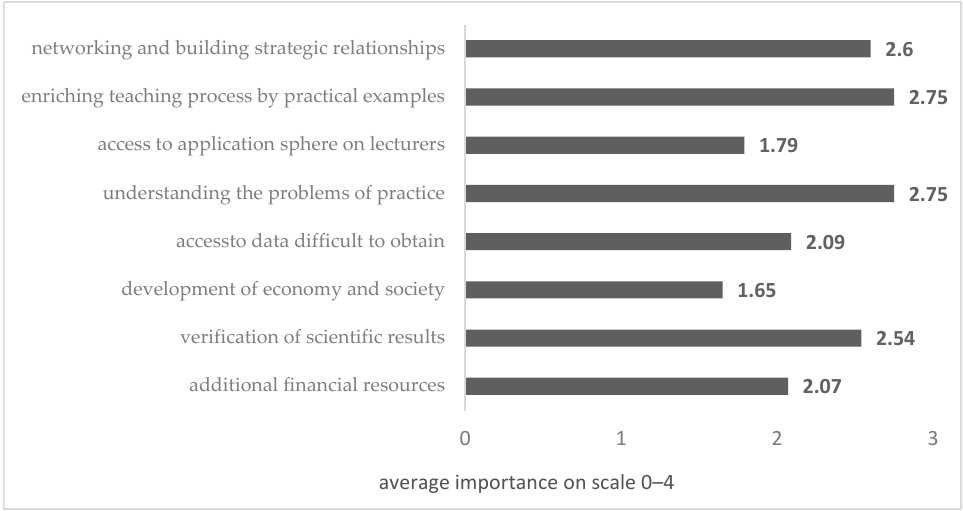
Figure 3. Expected benefits from academic engagement . Table 2. Vertical hierarchy of academics’ attitudes towards barriers of academic engagement .